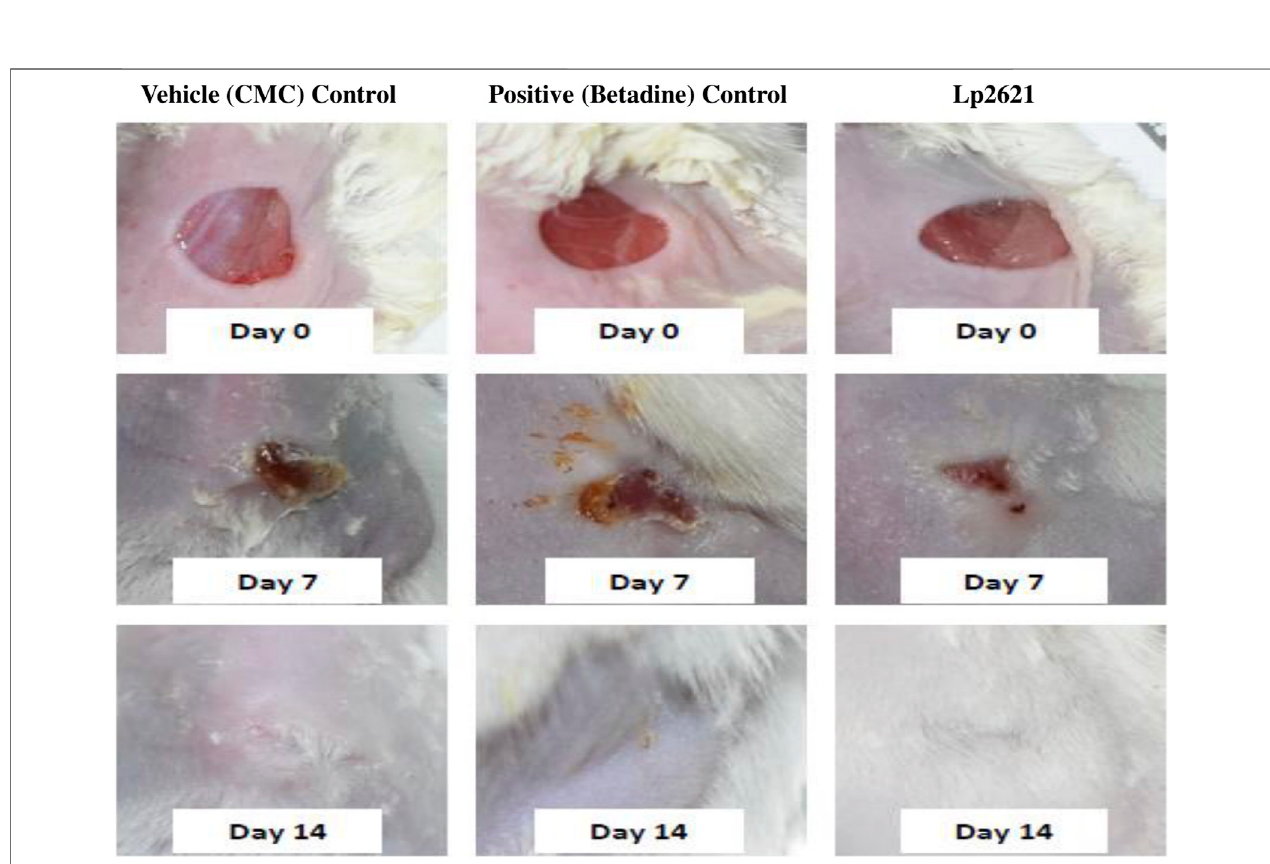
FIGURE 7 | Full-thickness excision wounds were created in mice. Representative photographs from the mice showing macroscopic wound closure on different day ’ s post-injury.